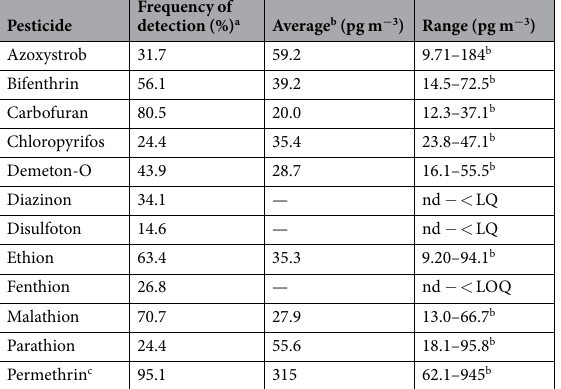
Table 4. Concentration of pesticides detected in all sampling sites (Maré Island, Itaparica Island and Naval Base). a Frequency of detection was calculated considering samples with concentration above the limit of detection (LOD). b Were considered only concentration above the limit of quantification (LOQ). c Sum of the permethrin I and permethrin II